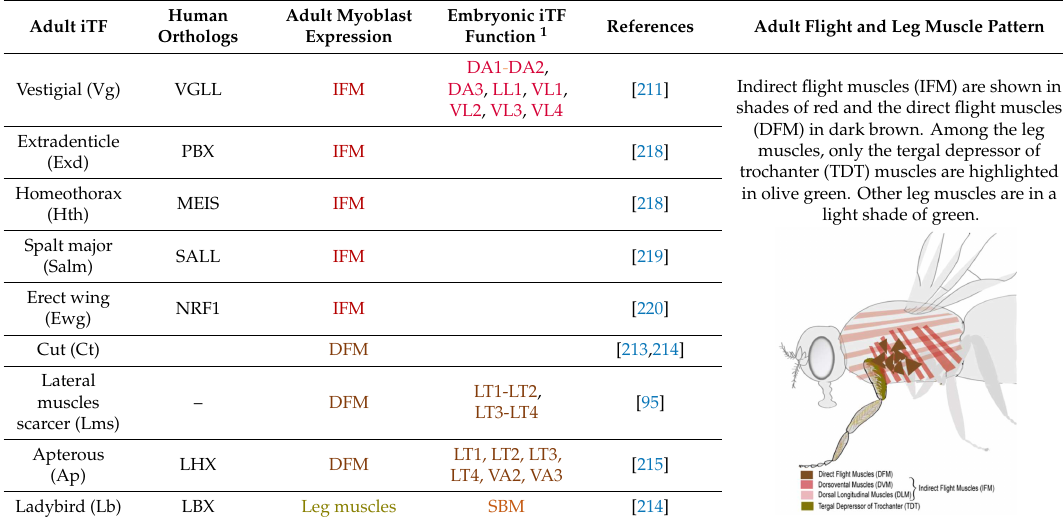
Table 2. The iTF expression patterns in myoblasts of adult muscles.